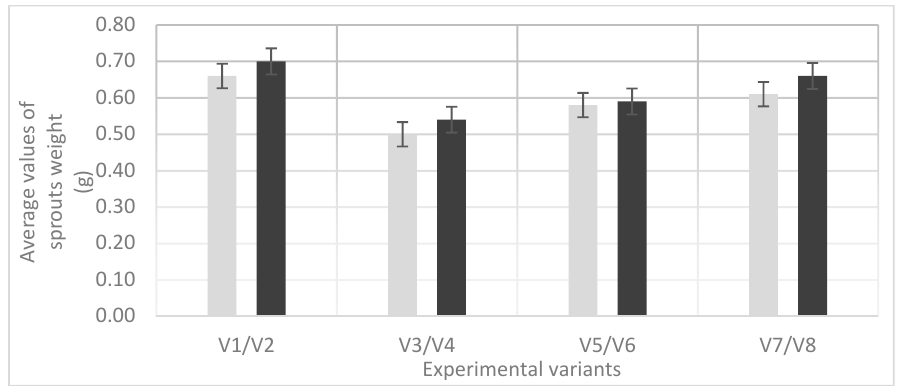
Figure 3. The medium values of Lepidium sativum L. sprouts’ weight on gauze (V1 control, illuminated with sunlight; V3, illuminated with white LED; V5, illuminated with blue LED; and V7, illuminated with red LED experimental variant) or biochar (V2 control, illuminated with sunlight; V4, illuminated with blue LED; V6, illuminated with blue LED; and V8, illuminated with blue LED experimental variant). Data acquired from the experiment were statistically investigated and were expressed as the mean ± SD (standard deviation). Bars are one standard deviation.